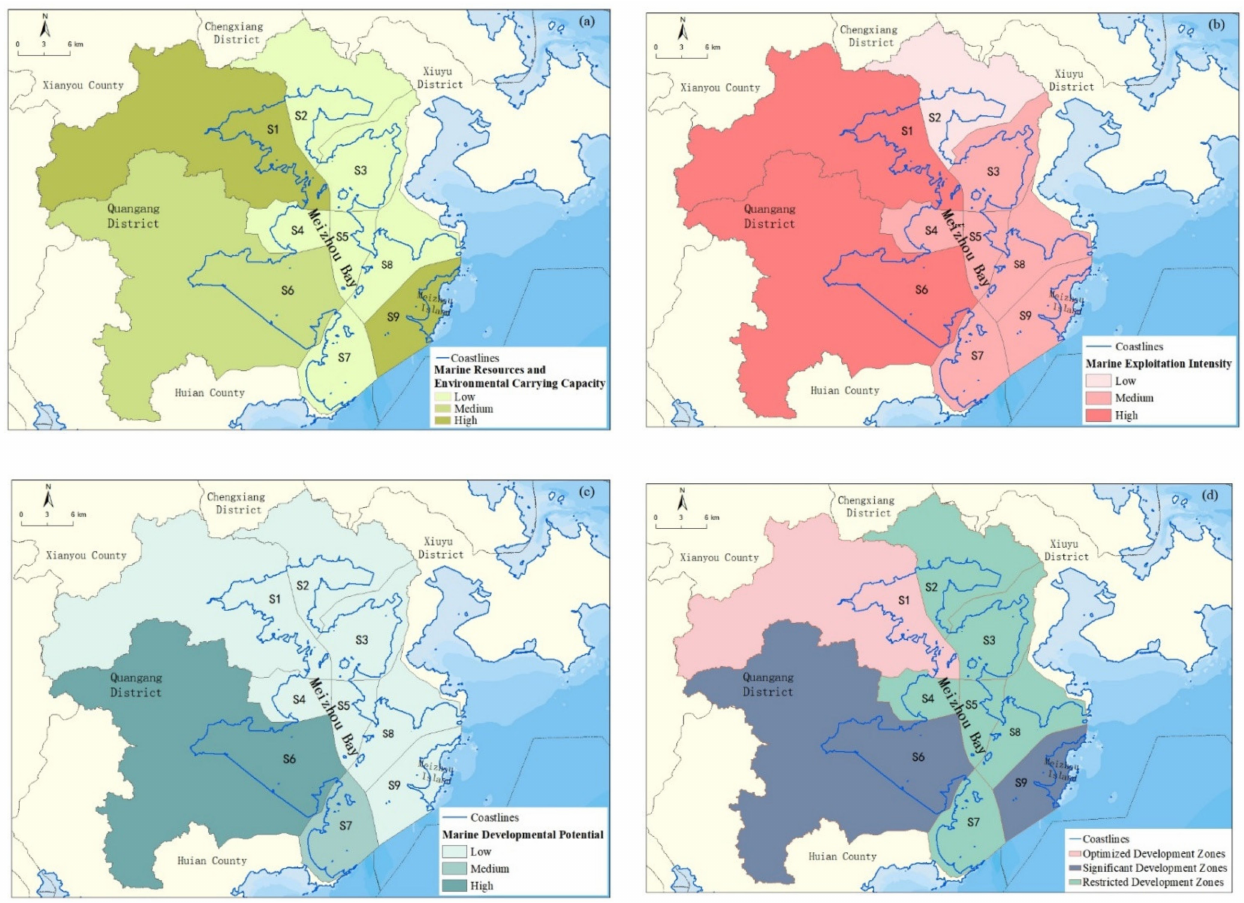
Figure 7. Comprehensive evaluation results for the MMFOZ in Meizhou Bay: ( a ) marine resources and environmental carrying capacity, ( b ) marine exploitation intensity, ( c ) marine developmental potential, and ( d ) final MMFOZ